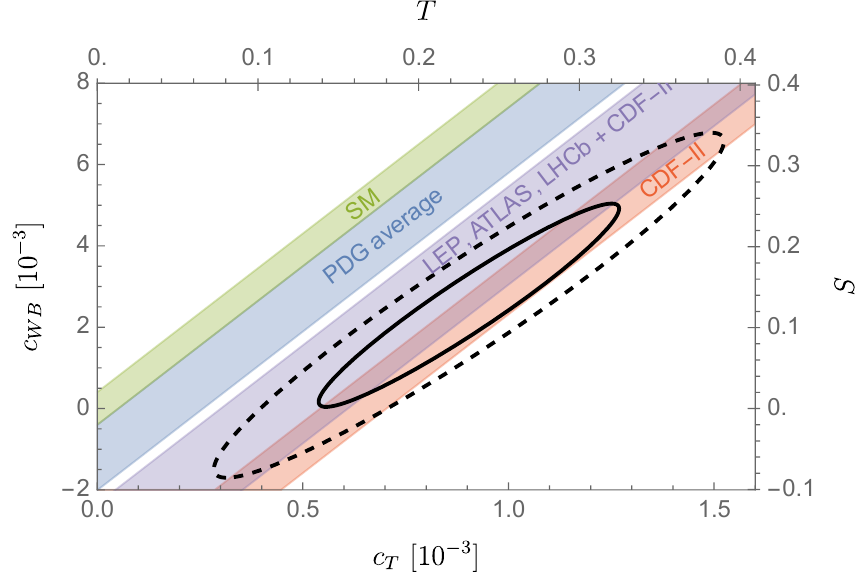
Figure 2 . The fit results for coefficients c T and c WB along with expectation bands for different m W measurements: SM (green), PDG average (blue), naive average (purple), and the new results from CDF (red). The 1 σ (solid) and 2 σ (dashed) contours indicate the values from the